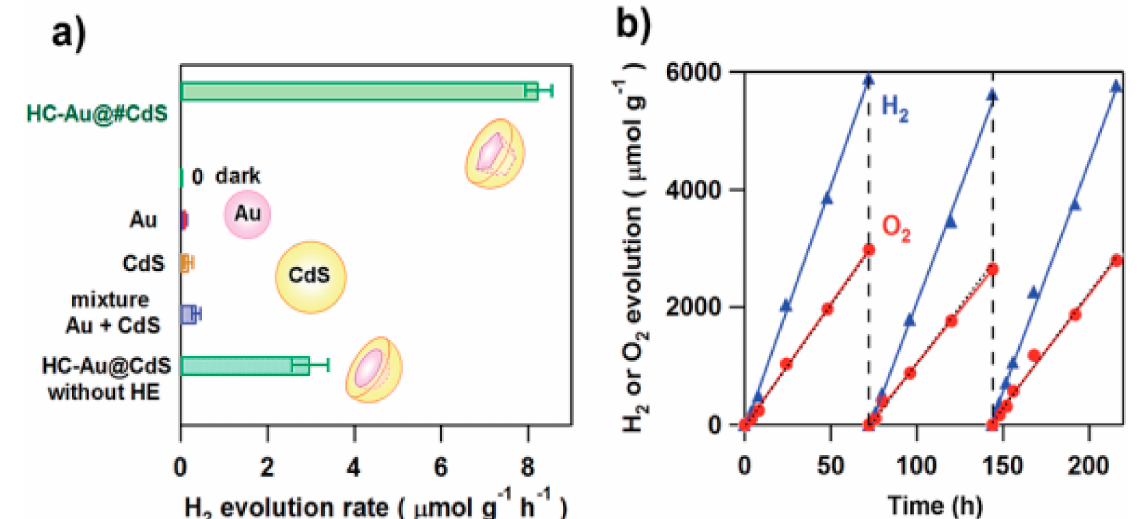
Figure 56. ( a ) The comparison of the H 2 evolution rate for HC-Au(d Au = 5.5 nm)@#CdS(/CdS = 1.9 nm), Au colloid, CdS and a mixture of Au and CdS under red-light illumination ( λ ex = 640 nm) or dark conditions. ( b ) Repeated water splitting by HC-Au(d Au = 12.1 nm) @#CdS(/CdS = 2.1 nm) under red-light illumination. Figures are taken from ref. Reproduced with permission from Nano scale Adv. [454], Copyright 2019, RSC.